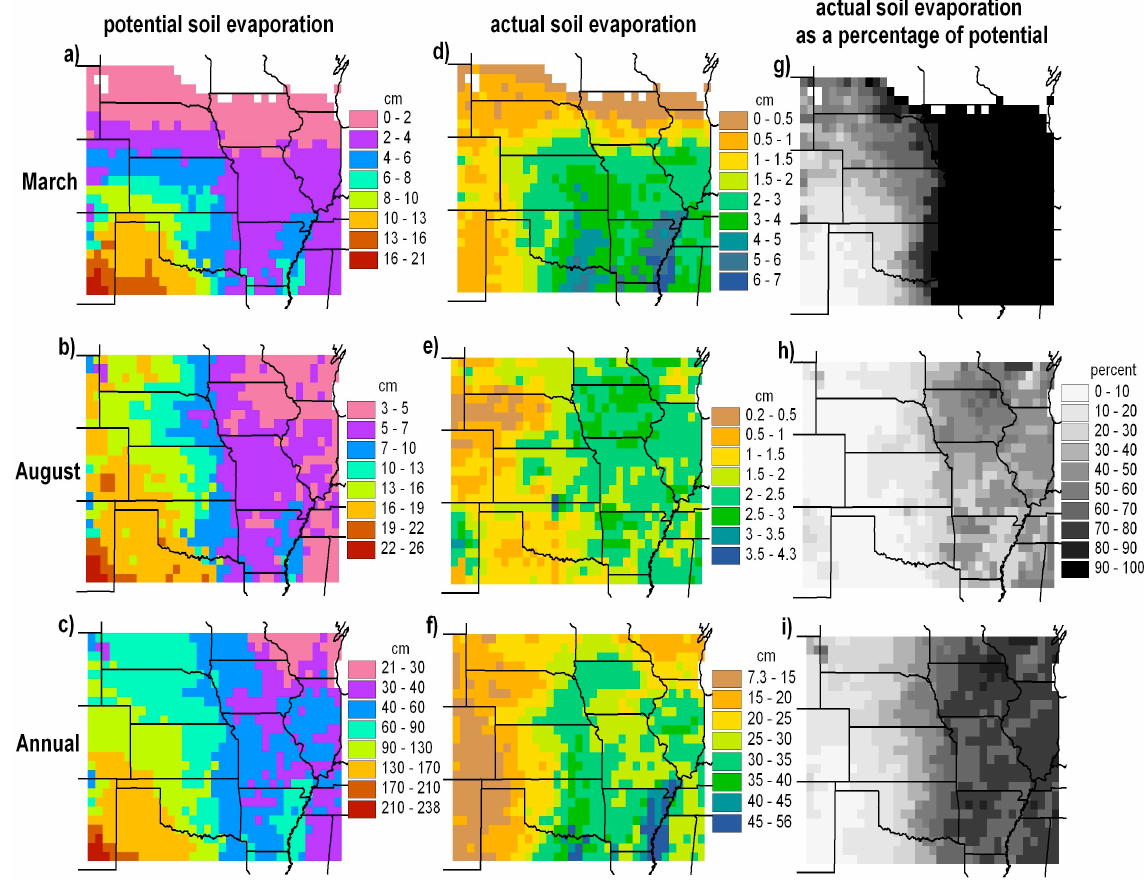
Fig. 10. Average potential soil evaporation, actual soil evaporation and actual as a percentage of potential for March, August and the entire year